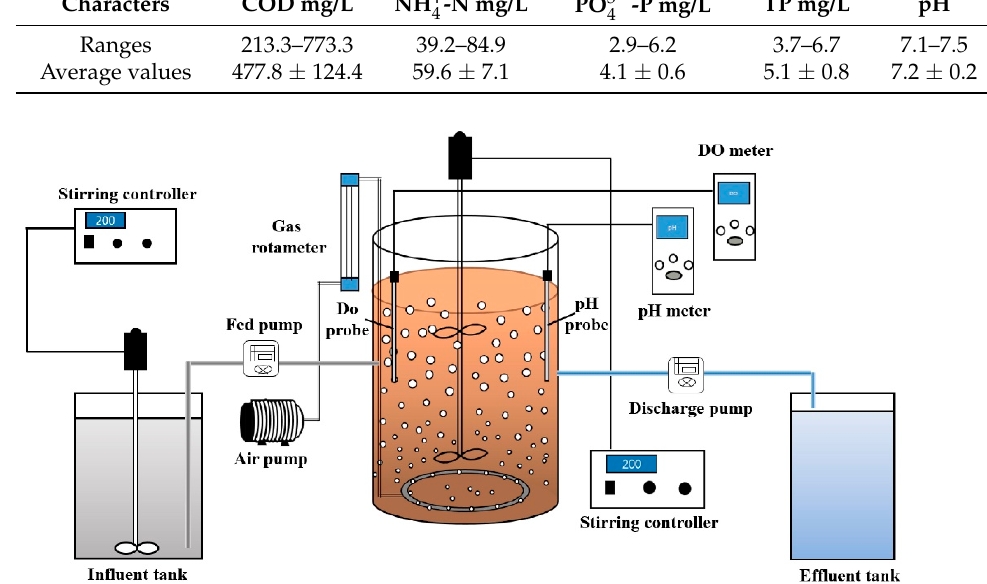
Figure 1. Schematic of the experimental